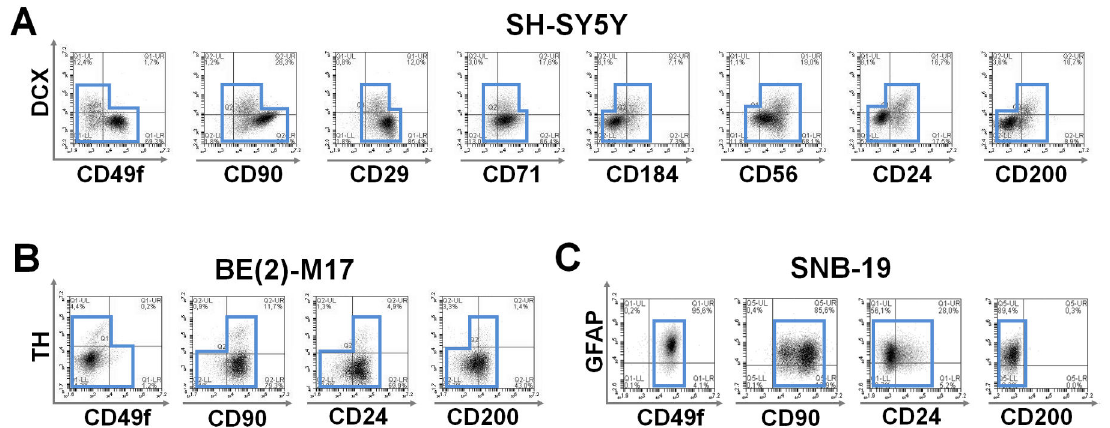
Figure 6. Combinatorial detection of known neural intracellular markers plus a panel of candidate surface antigens in human cell lines. ( A ) In SH-SY5Y cells CD49f, CD90 HIGH and CD29 expression clustered distinct from doublecortin (DCX)- positivity, while subsets of CD56, CD24 and CD200 closely correlated with neuronal differentiation (DCX+). Patterns of exclusive positivity on either the y- or the x-axis (upper left and lower right quadrant) yield CD marker candidates for negative selection strategies. Patterns of shared intracellular and surface expression (upper right quadrant) are suitable for positive selection strategies. Blue outlines illustrate co-expression patterns. ( B ) Co-localization analysis of the catecholaminergic intracellular marker tyrosine hydroxylase (TH) is shown on BE(2)-M17 cells. The TH-positive subset stained negative for the putative proliferative indicator CD49f but was colocalized with CD90, CD24 and CD200 in this cell line. ( C ) Co-localization analysis of the glial intracellular marker glial fibrillary acidic protein (GFAP) is shown on SNB-19 cells. In contrast to the other neural cell lines analyzed, GFAP-positive subsets stained positive for CD49f, and also CD90. CD24 was present to a lower degree and the putative neuronal marker CD200 in this context was virtually